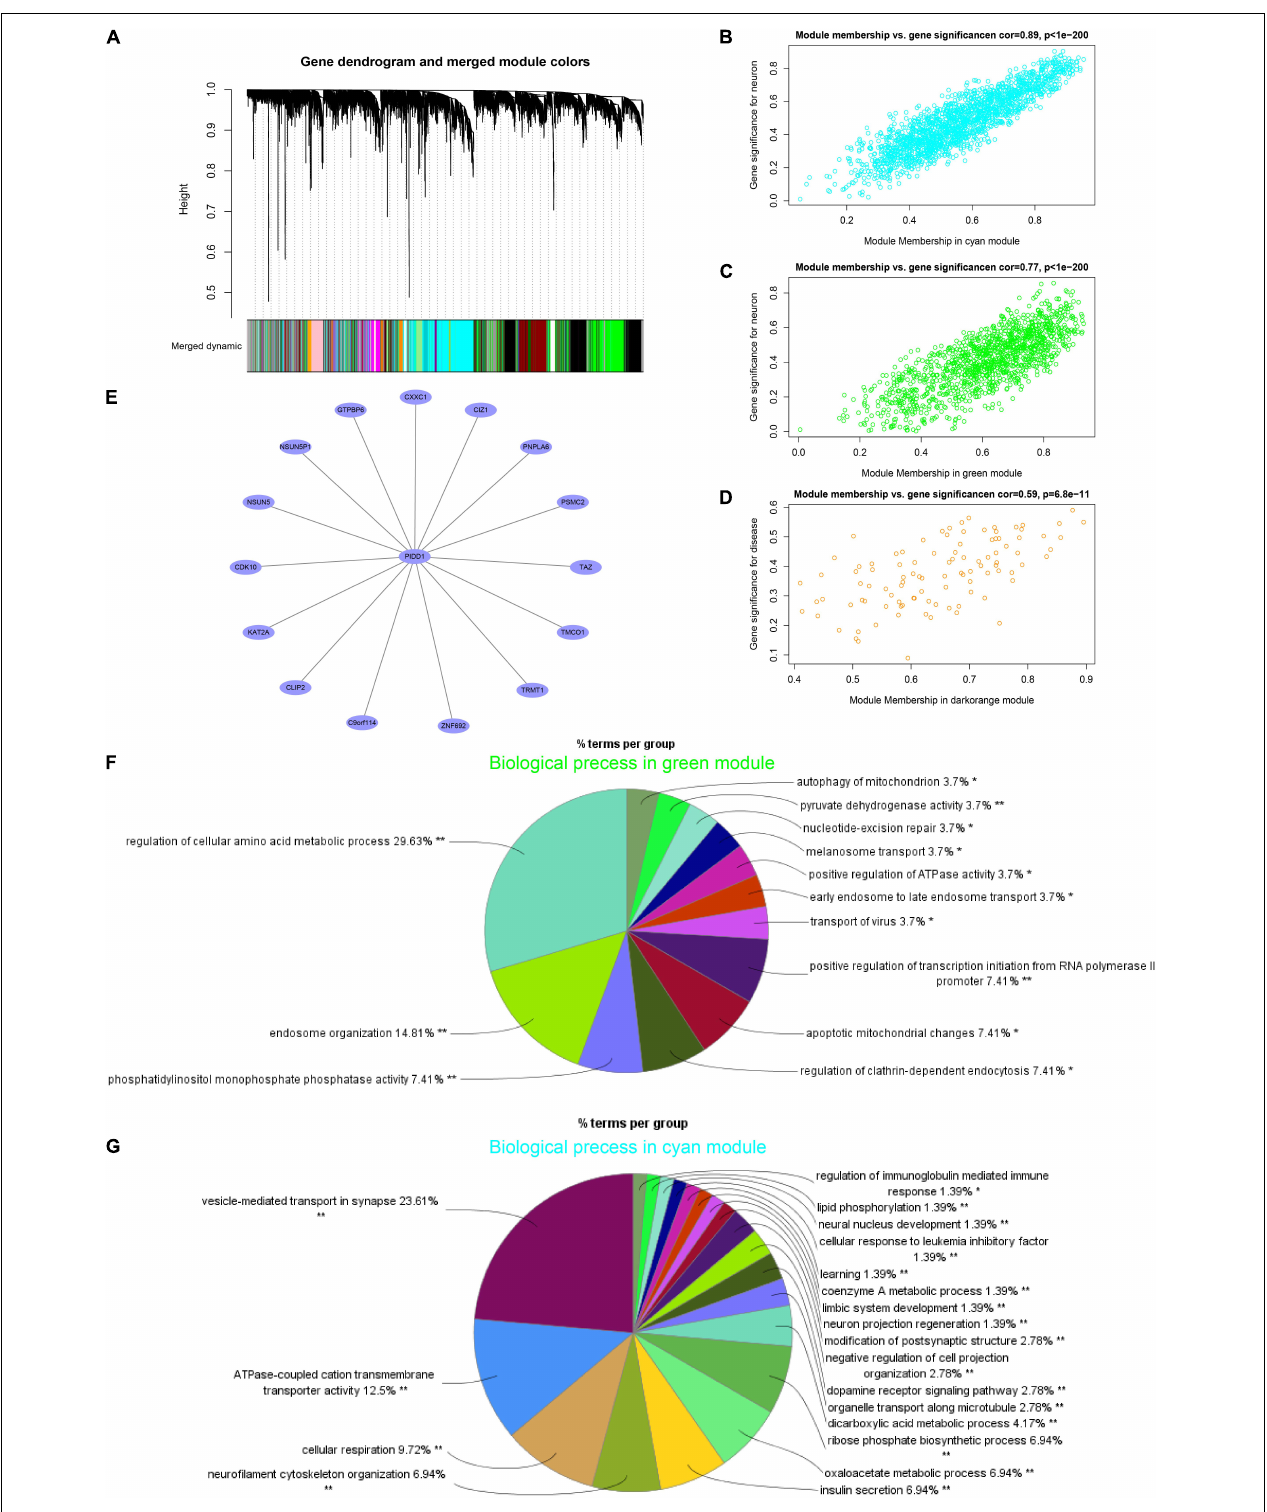
FIGURE 3 | p53-induced death domain protein 1 ( PIDD1 ) as a hub gene in the module of PD by the WGCNA analysis in SN. (A) Dendrogram of all genes clustered based on a dissimilarity measure (1-TOM). (B–D) Correlation between the module membership and the gene significance in cyan, green, and dark-orange modules, separately. (E) The network graph of the hub gene PIDD1 of the PD-related dark-orange module. (F,G) The biological process of the GO enrichment analysis of filtered genes in green and cyan modules, separately. * p < 0.05, ** p < 0.01.